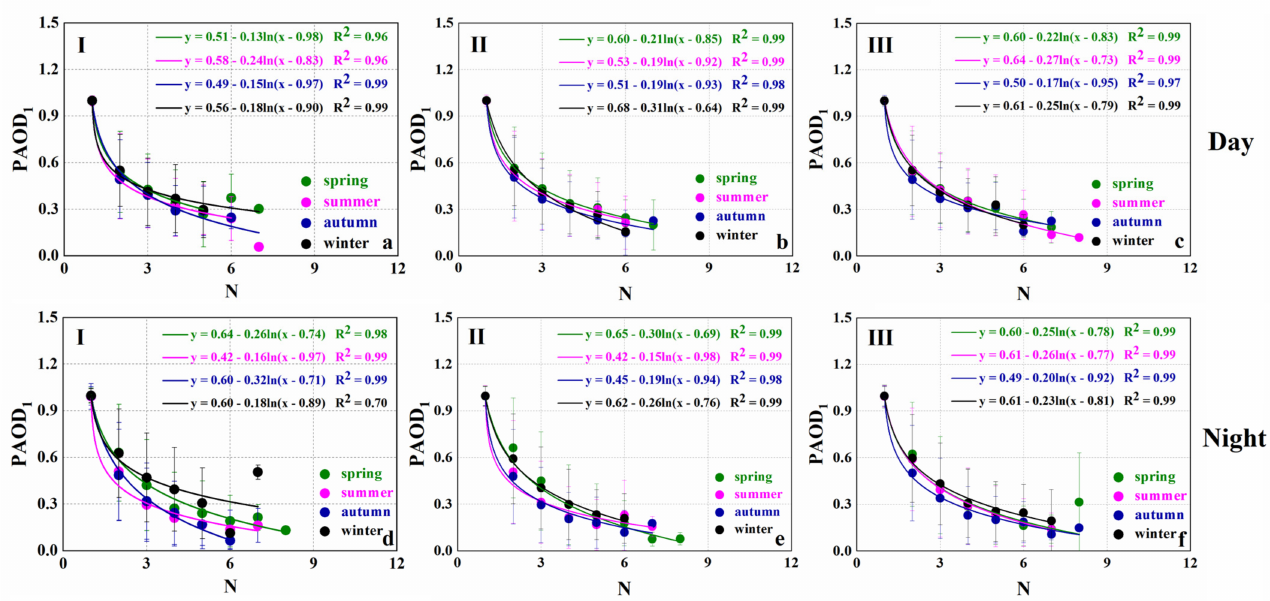
Figure 19. The correlation between PAOD1 and N over Saudi Arabia from 2007 to 2019. ( a , d ) represent regions I, ( b , e ) represent regions II, and( c , f ) represent regions